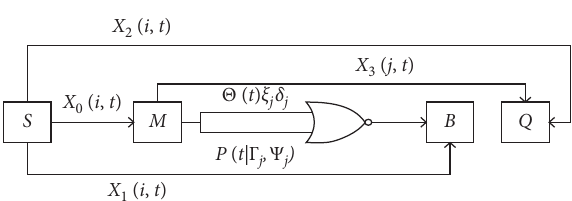
Figure 2: The dynamic process of consumer emergence behavior based on the SMBQ